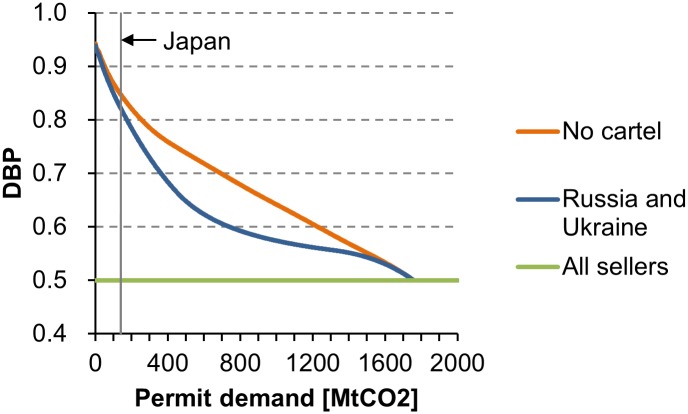
Impacts of seller cartels on the DBP.Calculated from the data of Fig 1. The cartel of Russia and Ukraine controls 75% of the aggregate permit supply.